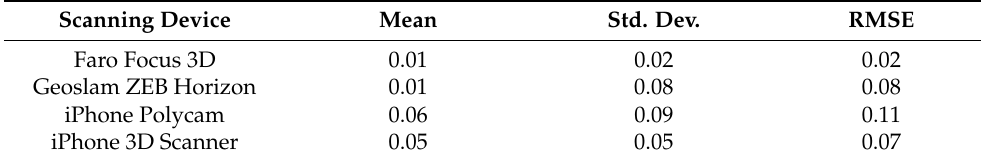
Table 3. Statistical evaluation of accuracy—lengths between reference crosses in transverse profiles. Scanning